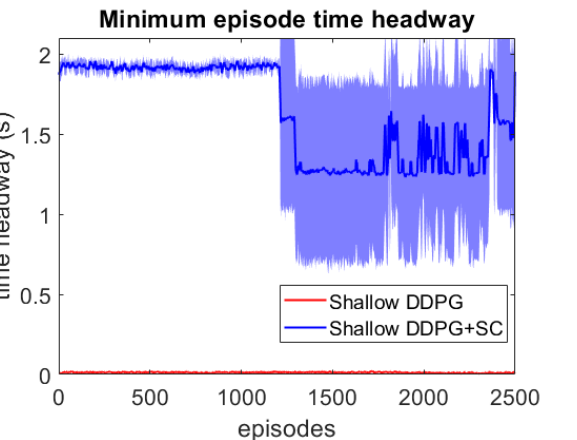
Figure 9. Comparison of the shallow vehicle following agents’ minimum TH per episode over adversarial training runs with lead vehicle velocity limits v lead ∈ [ 12,30 ] m/s. Averaged over 3 runs, with standard deviation shown in shaded